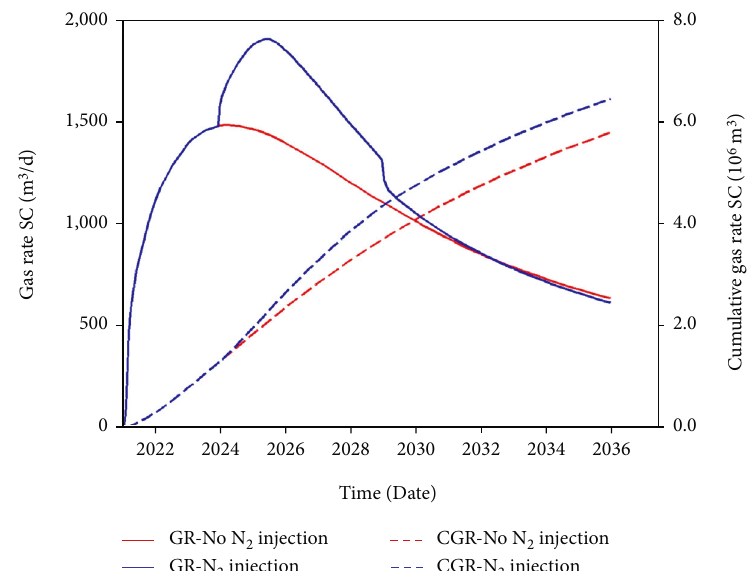
Figure 3: CBM production curves of N production, and CGR represents cumulative gas production. SC denotes surface